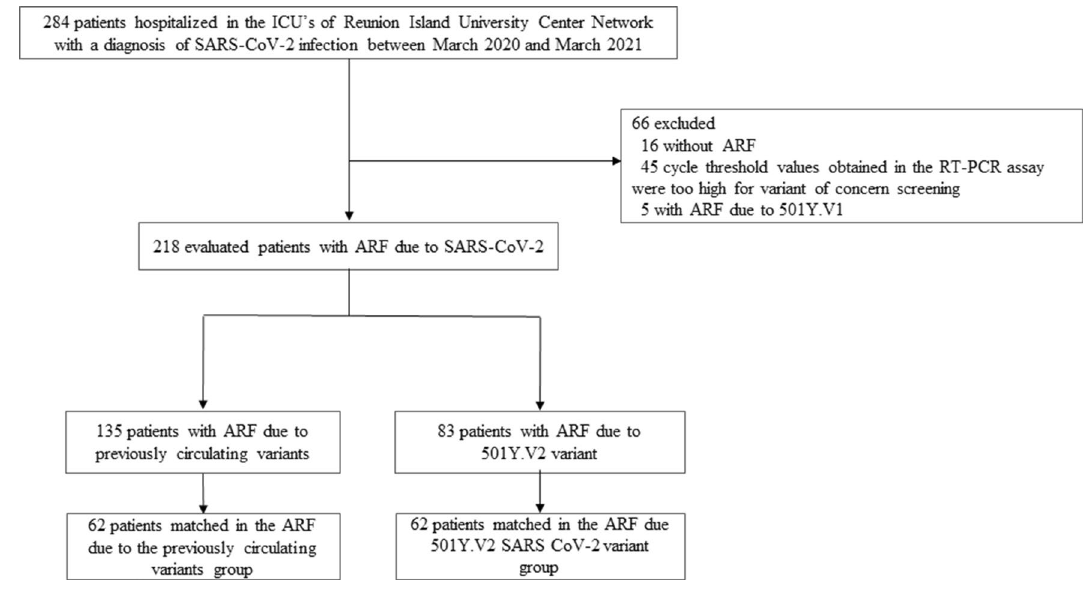
Figure 1. Selection of the study